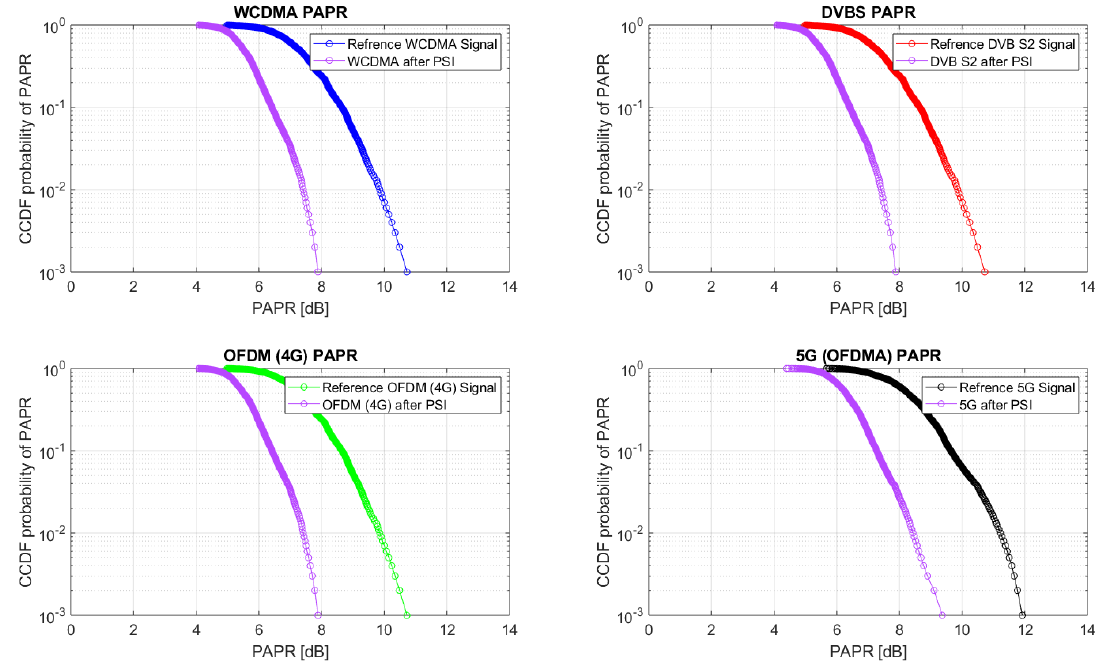
Figure 15. CCDF of PAPR reduction performance of PSI technique on multi